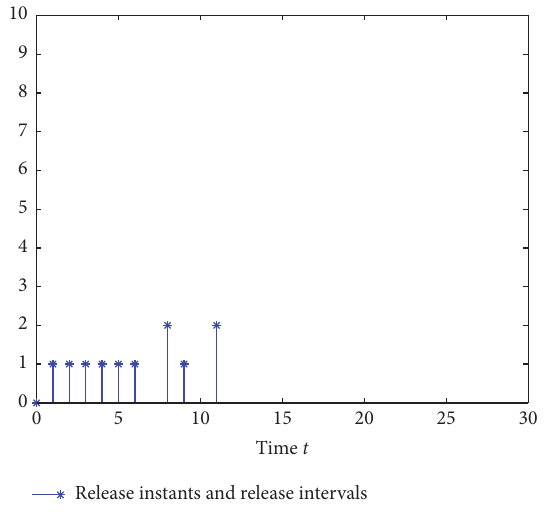
Figure 7: Release instants and release